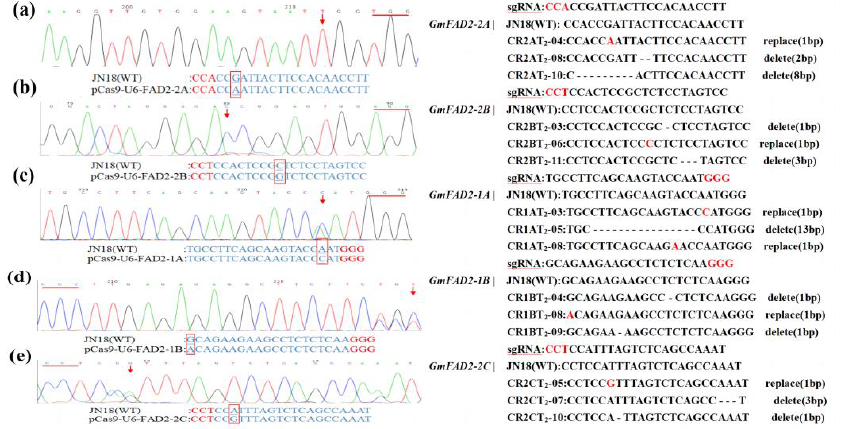
Figure Figure 7. Part of Sanger sequencing results and GmFAD2 gene sequence mutation sites: ( a ) pBGK015Cas9-U6-FAD2-2A; ( b ) pBGK015Cas9-U6-FAD2-2B; ( c ) pBGK015Cas9-U6-FAD2-1A; ( d )